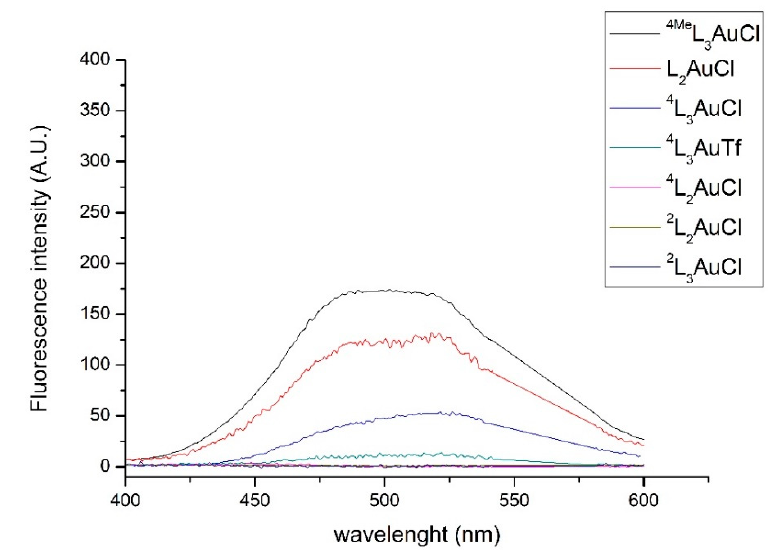
Figure 2. Emission spectra recorded in Hepes / methanol 22.86 µ M solutions of polyphosphane gold(I) chloride compounds ( λ exc = 280 nm). Compounds 4 L 2 AuCl, 2 L 2 AuCl, and 2 L 3 AuCl show weak intrinsic emissions and their spectra falls in the baseline intensity. Table 2. List of fluorescence data for the gold(I) compounds once treated with DHFR (DiHydroFolateReductase) and DHFR/NADPH (Nicotinamide Adenine Dinucleotide Phosphate), with the corresponding Kd values.